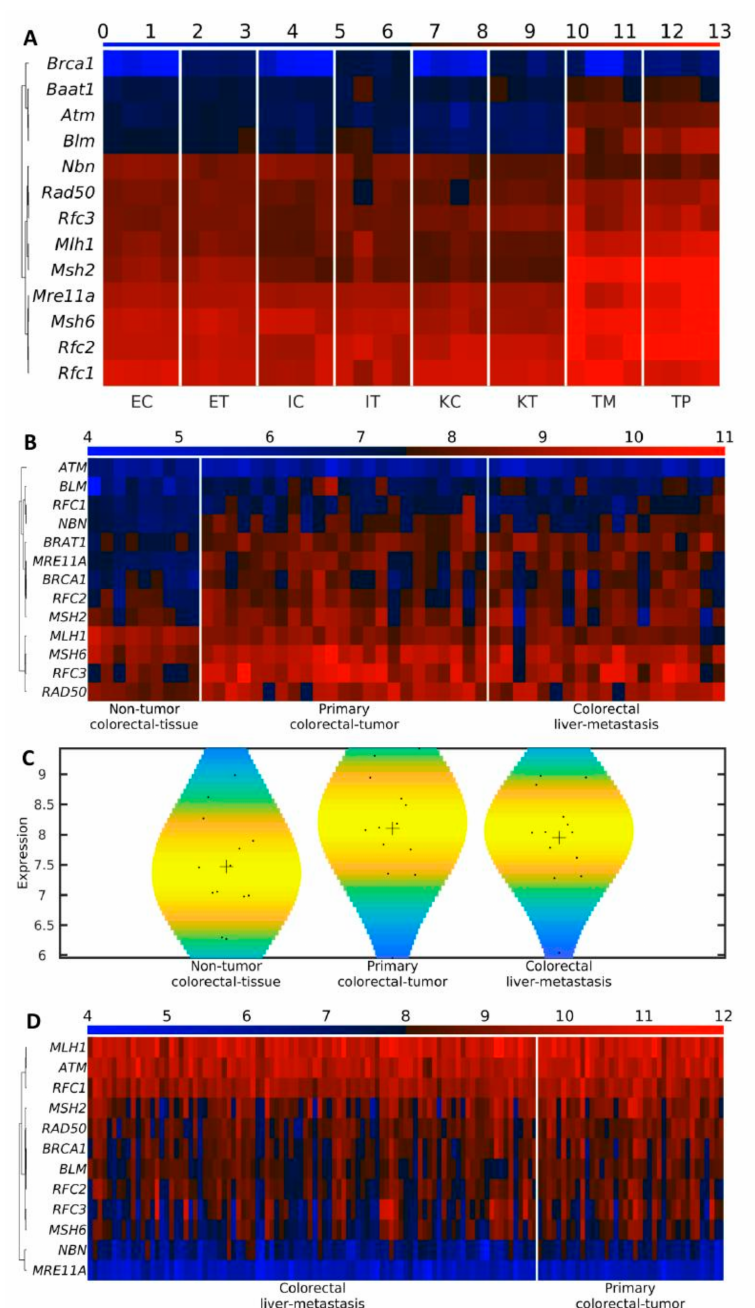
Figure 6. BRCA1 is the last BASC gene activated in TME. Heatmap of the expression of BASC-related genes in ( A ) mouse liver cell samples. The samples are denoted with E, I, and K for endothelial, Ito, and Kup ff er cells, C and T for control and TME cells, and TP and TM denote the CRC primary and tumor liver metastasis cells, respectively. Higher gene expression corresponds to a redder color (for each mRNA sample, we used 4 biological replicates); and ( B ) human non-tumor colorectal tissue, primary colorectal tumor, and colorectal liver metastasis from 51 patients [39]. Higher gene expression corresponds to a redder color. ( C ) Violin plot of the expression distribution of human BASC-related genes. Black crosses represent mean positions. Black points represent the spread of the expression of the genes used to build the distributions. ( D ) Heatmap of the expression of BASC-related genes in human primary colorectal tumor and colorectal liver metastasis from 133 patients [40]. Higher gene expression corresponds to a redder